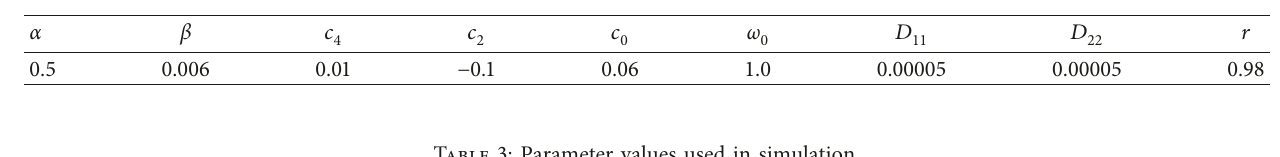
Figure 2: A comparison between the analytical solutions (solid blue lines) and the numerical results (discrete blue dots). Table 2: Parameter values used in simulation.